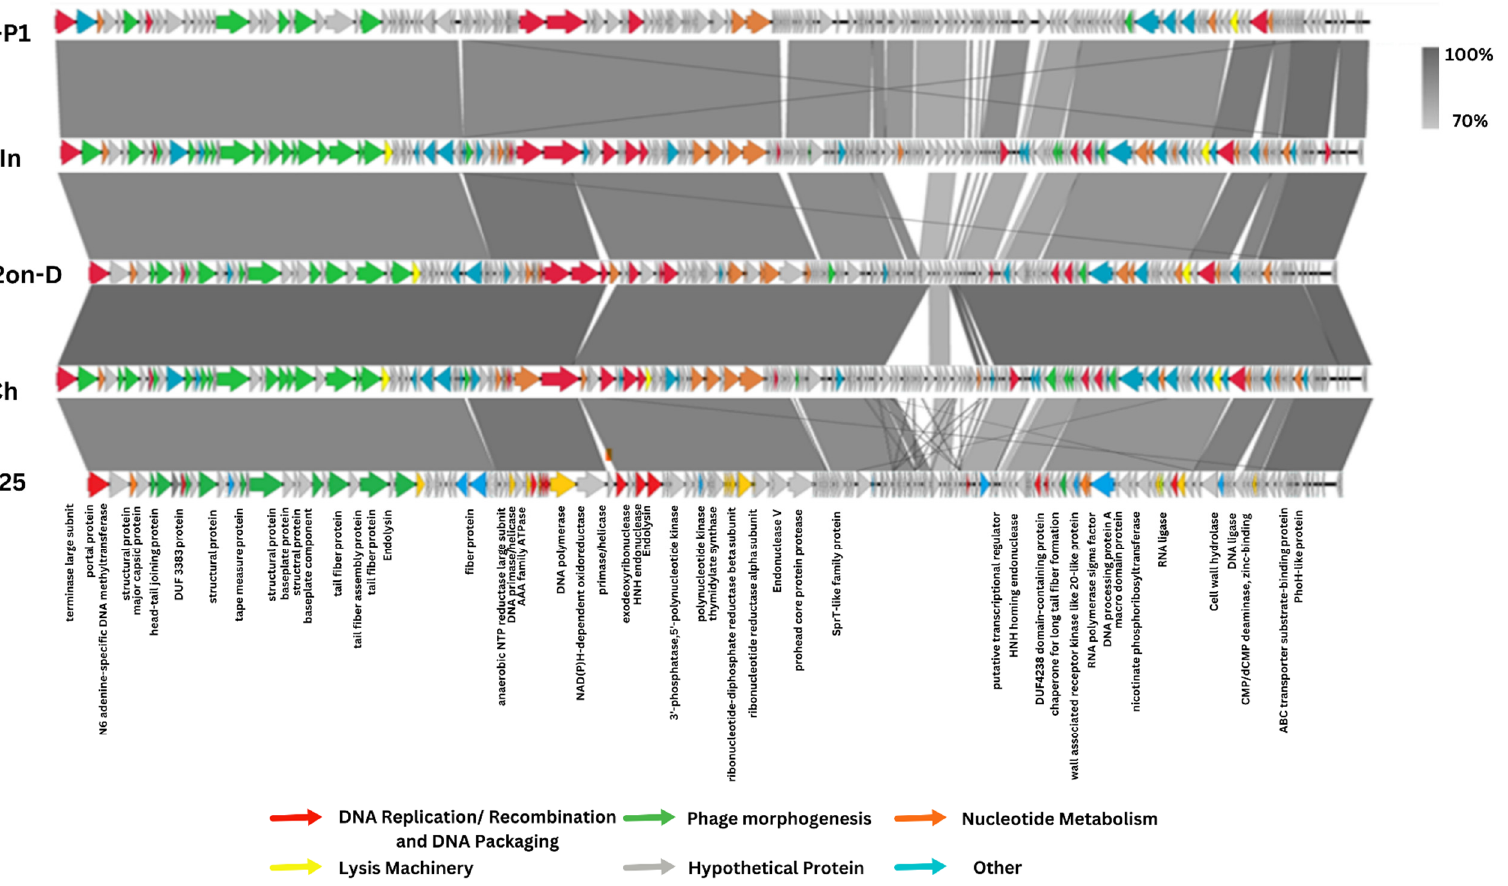
Figure 2. Comparative genome analysis of the P. aeruginosa phages PsIn, PsCh, Ps12on-D, Ps25, and PAK_P1. The direction of transcription is shown by arrows next to predicted ORFs. According to the key provided at the bottom of the graphic, arrows are colored according to their functions. The corresponding ORFs are presented with (if available) functional annotations.